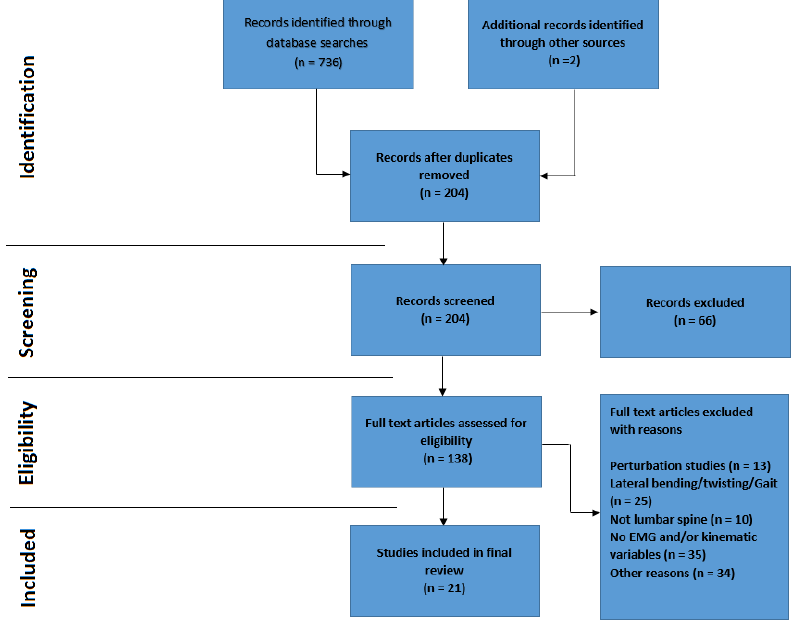
Figure 1. Prisma flowchart. Note: Additional articles (n = 2) were sourced via a manual search through the reference lists of the articles identified in the database search.